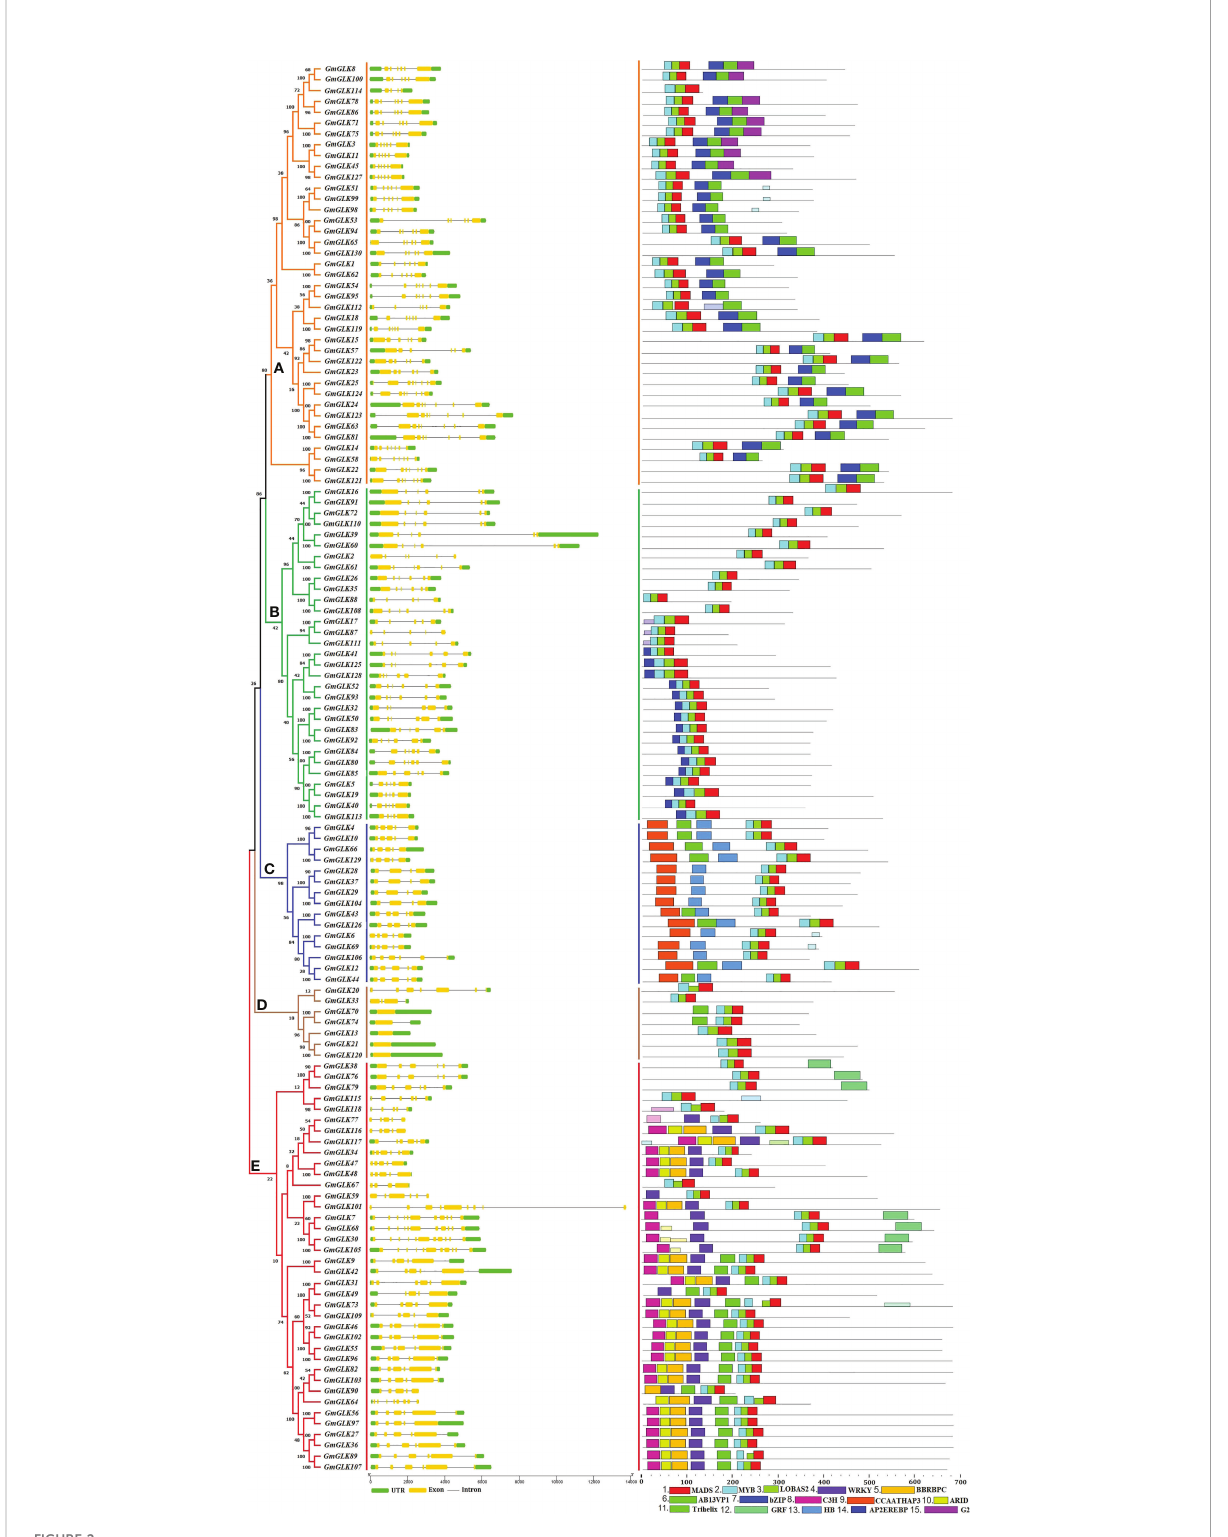
FIGURE 2 Schematic representation of the structural organization and motif composition of the soybean GLK genes. The ML approach evolutionary tree is presented on the left, which was clustered into fi ve major groups (A – E) , preceded by the GLK gene structure, including exons and introns, which are represented by yellow color boxes and black lines, respectively. The preserved motifs are shown in different colors. Non-conserved regions are shown in black